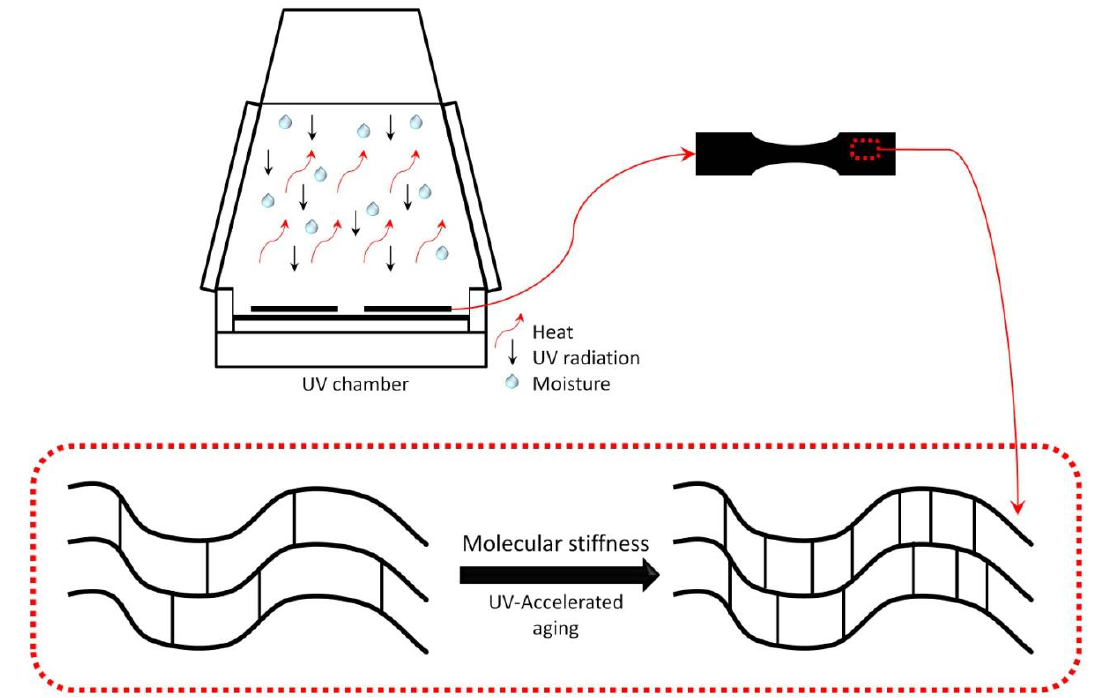
Figure 7. Schematic diagram showing the increase of the molecular stiffness due to the increase of the cross-link density of the analyzed composites during the aging.